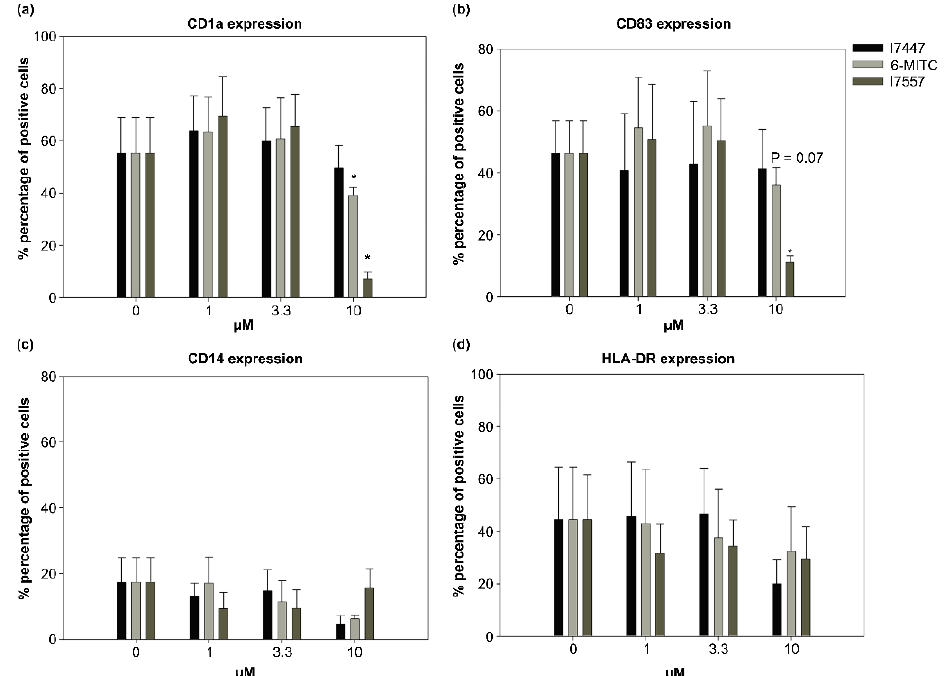
Figure 3. Effect of 6-MITC and its derivatives on the expression of the dendritic cell surface markers, CD1a and CD83. DCs were treated with 6-MITC/I7447/I7557 at concentrations of 0, 1, 3.3, and 10 µ M for 7 days. CD1a ( a ), CD83 ( b ), CD14 ( c ), and HLA-DR ( d ) expression was assessed by flow cytometry. ( a , b ) The 6-MITC and I7557 exhibited a dual effect on the CD1a and CD83 expression. * p < 0.05 in comparison to